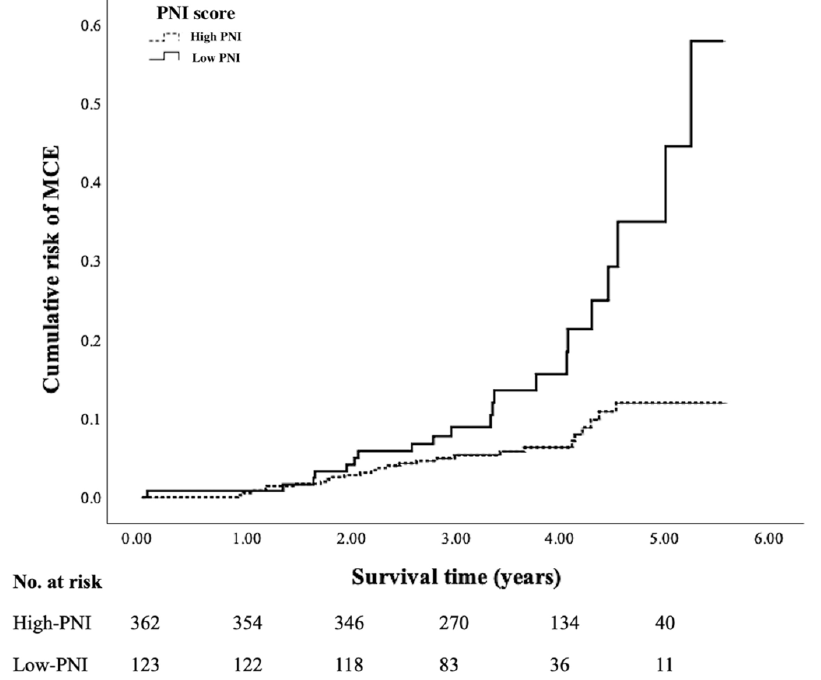
Figure 1. Cumulative incidence of MCEs between the low PNI and high PNI patients. Patients with low PNI scores showed a significantly higher risk of MCEs compared to those with high PNI scores (17.07%, 95% CI: 10.42 – 23.72% vs. 7.18%, 95% CI: 4.52 – 9.84%; p = 0.001). The multivariate-adjusted HR for the association between PNI levels and the risk of MCEs is shown in Table 2. After adjustment of gender, age range, lifestyle factors, and basic health status, patients at malnutrition risk determined by low PNI levels had a higher risk of MCEs than those at high PNI levels (HR: 2.593, 95% CI: 1.418 – 4.742, p = 0.002). In sensitivity analyses separately excluding the participants with a previous his- tory of myocardial infarction or stroke, reduced left ventricular ejection fraction (< 50%) at baseline, or missing data of MCEs during the follow-up, the directions of the associa- tion between malnutrition and MCEs risk were not significantly changed (Table S1). Additionally, redefining the primary outcome as traditional MCE or the cut-off value of PNI as the lowest tertile value (< 48.35) did not change the direction and significance of the association between malnutrition and long-term cardiovascular outcome (Table S1).